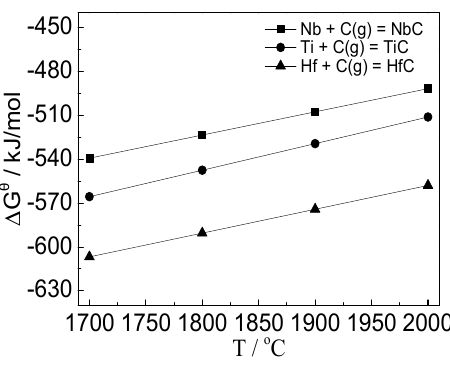
Figure 10. Standard Gibbs free energy change ΔG θ of the reactions between C and Nb, Ti, and Hf.